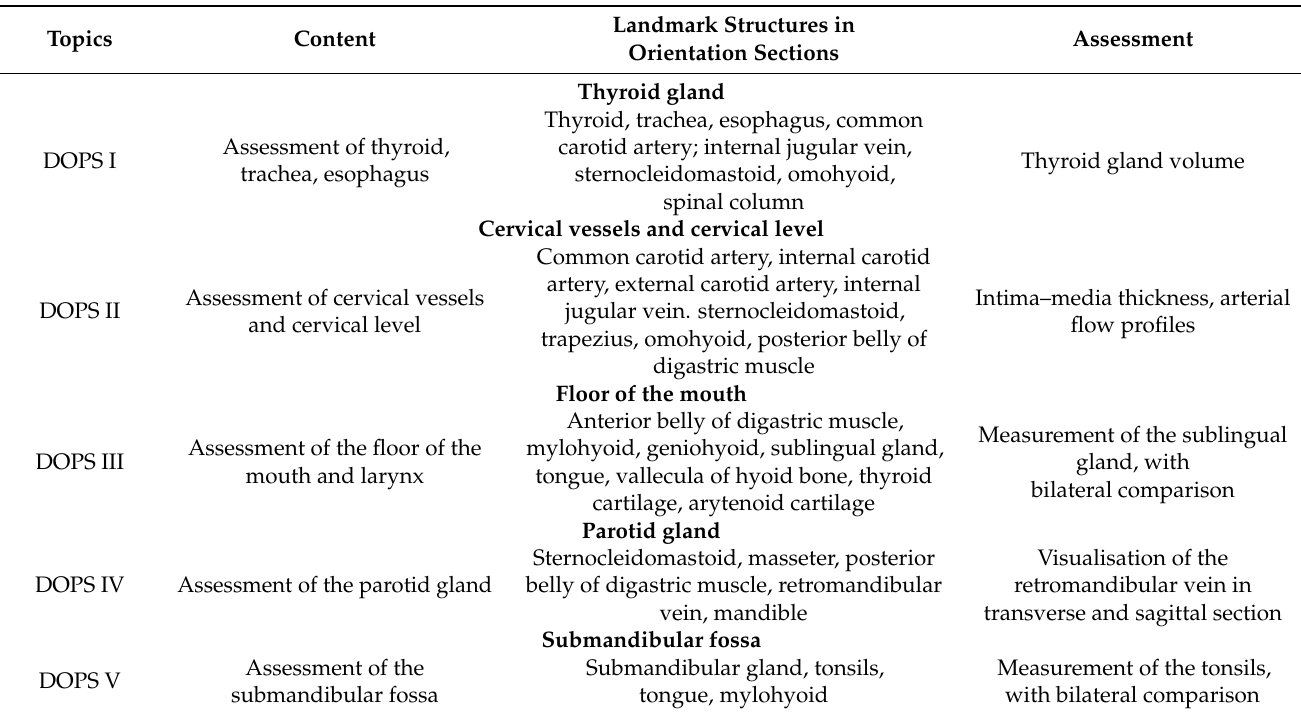
Table 1. Direct observation of procedural skills (DOPS) test topics in head and neck ultrasonography, with learning objectives and landmarks.